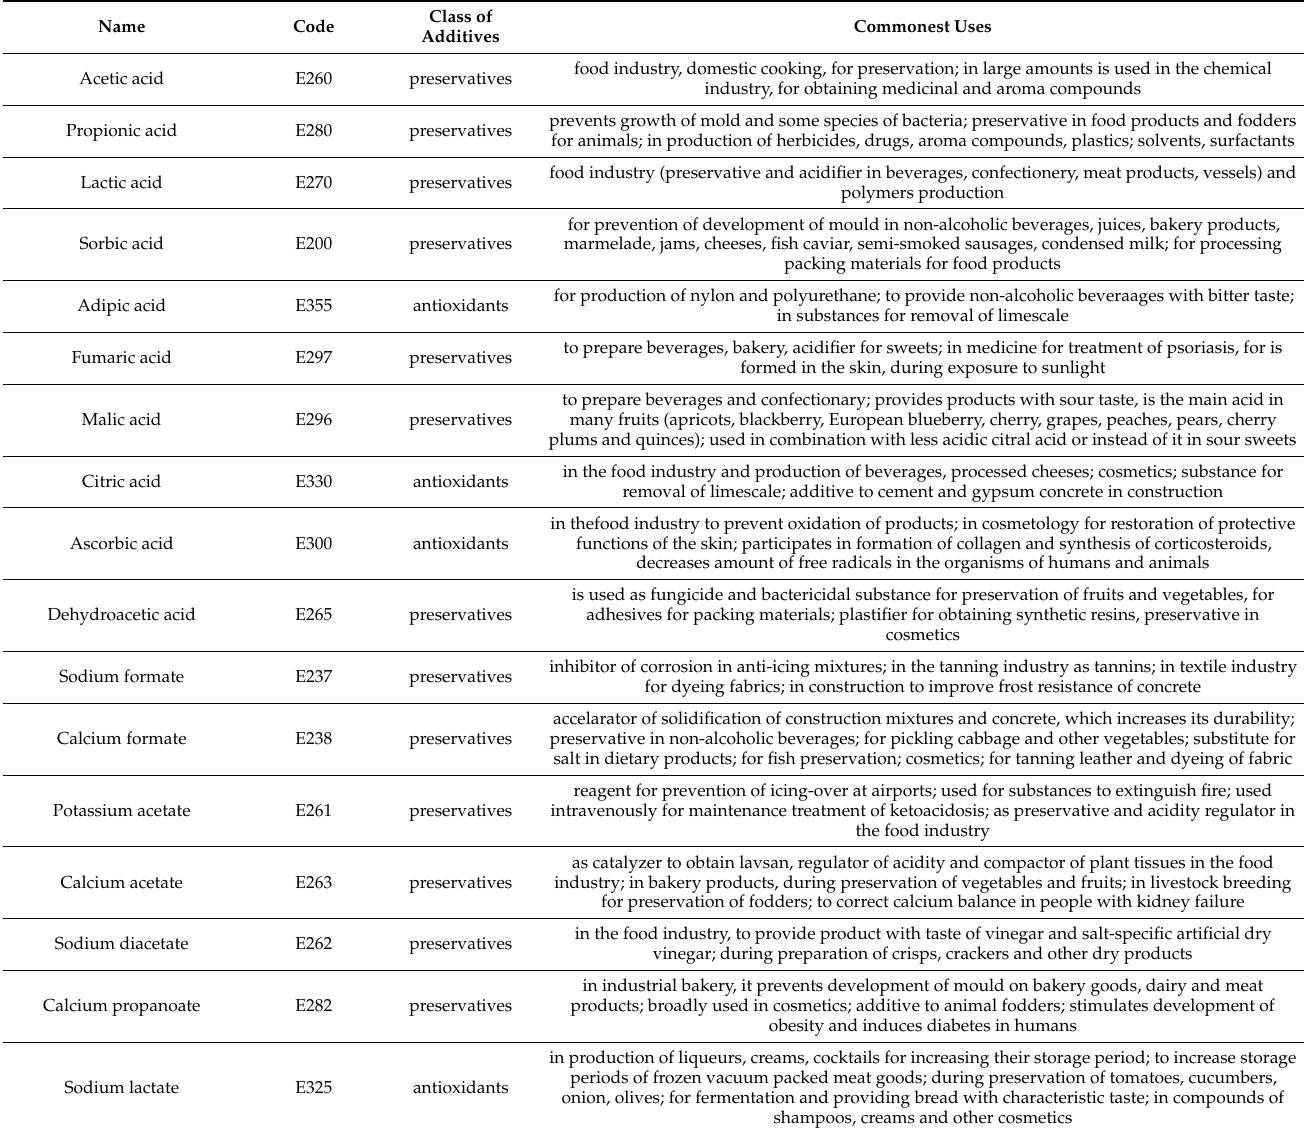
Table 1. Use of 32 organic food additives utilized for determining level of survivability of nematodes in the laboratory